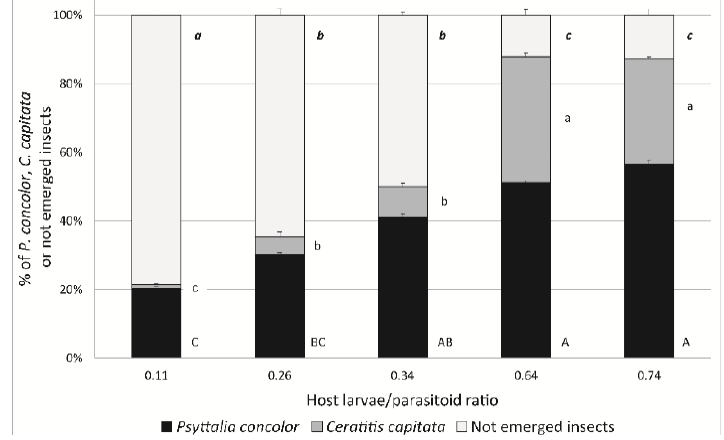
Figure 8. Percentages of emerged P. concolor and C. capitata adults and of not emerged insects in tests performed at 0 mm for 30 min and with different host larvae/parasitoid ratios. Different letters indicate significant differences.